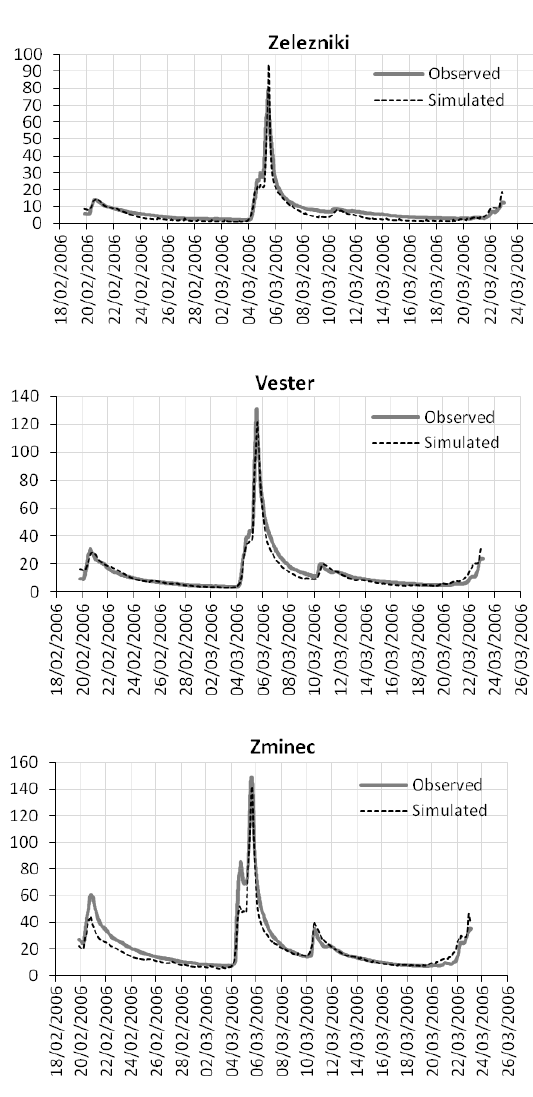
Fig. 4a. Model results for the calibration period, 19/02/2006 to Figure 4a: Model results for the calibration period, 19/02/2006 to 23/03/2006. 5